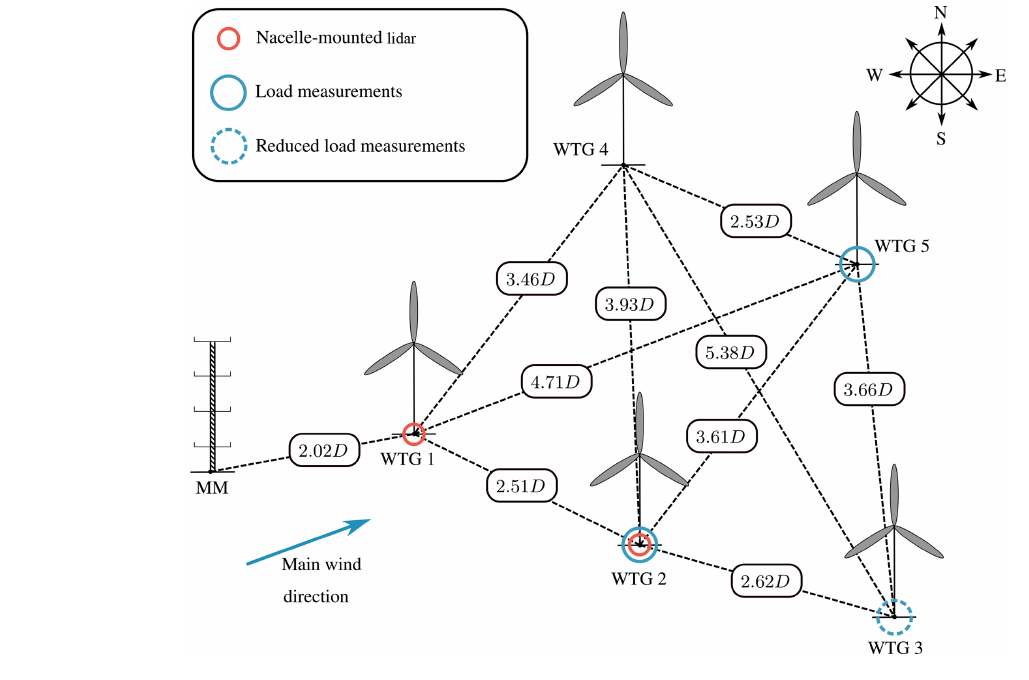
Figure 1. Wind farm layout with measurement equipment.